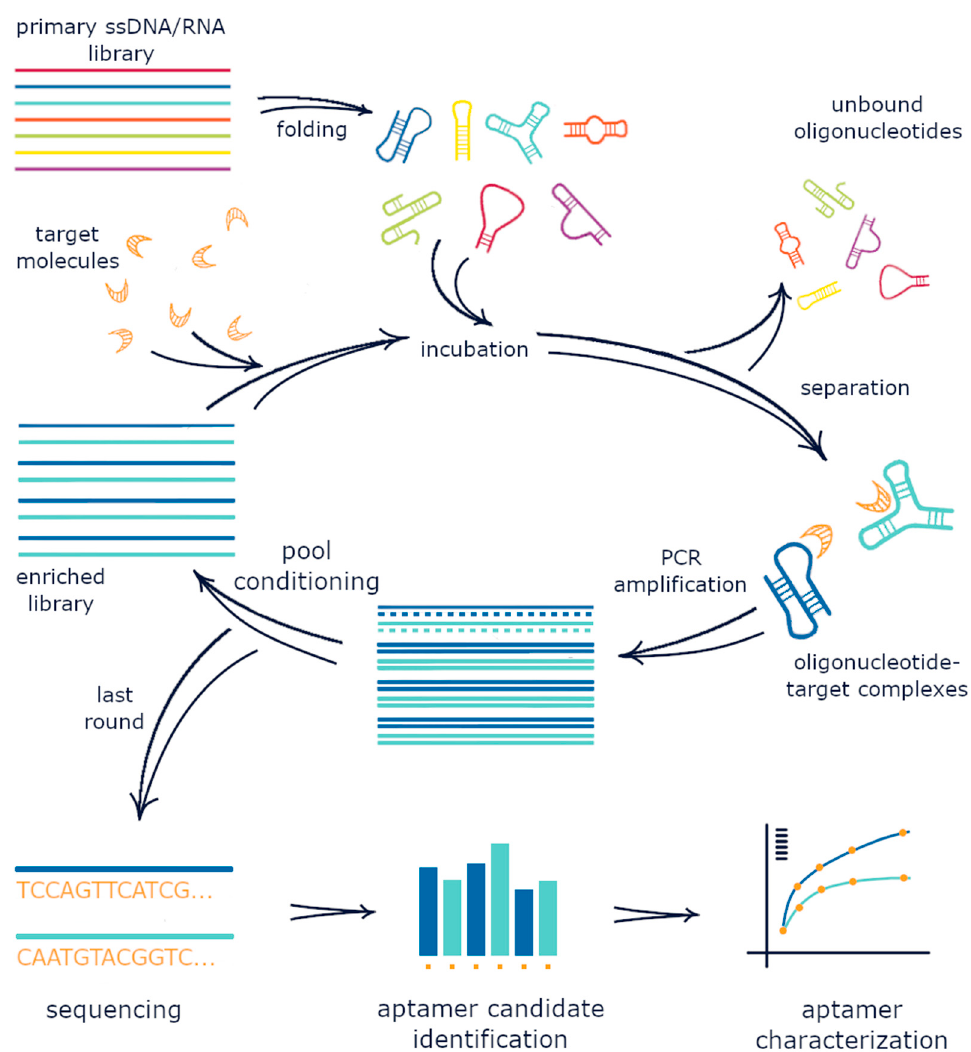
Figure 1. Illustration of the SELEX